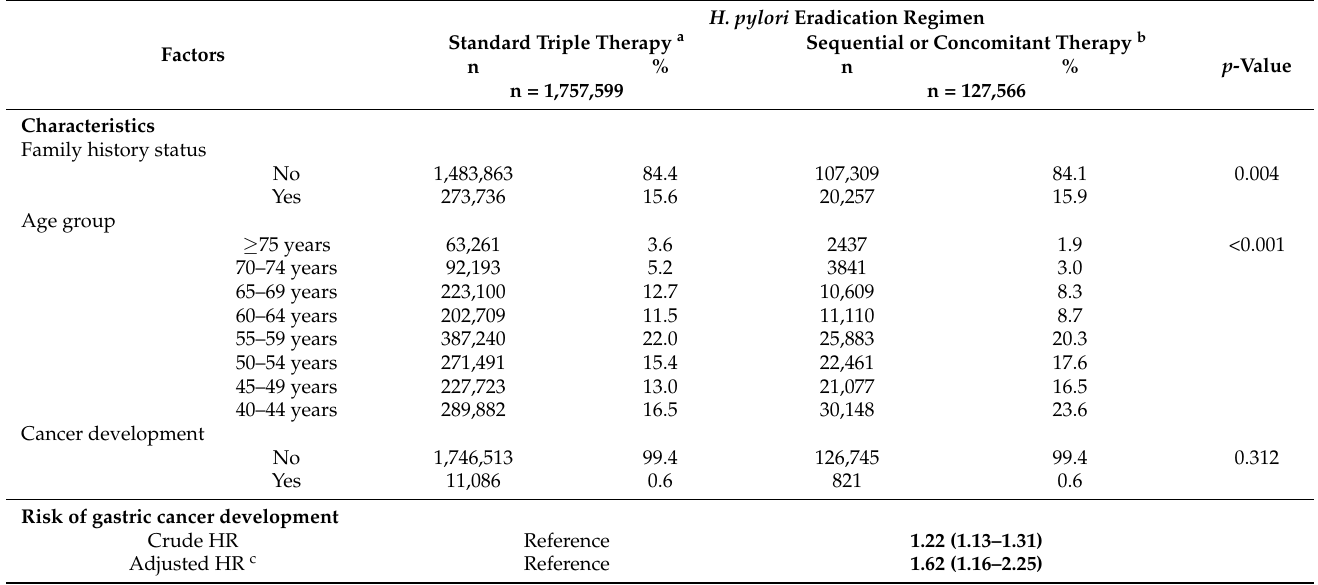
Table 4. Distribution of H. pylori eradication regimens according to family history, age group and cancer development status.